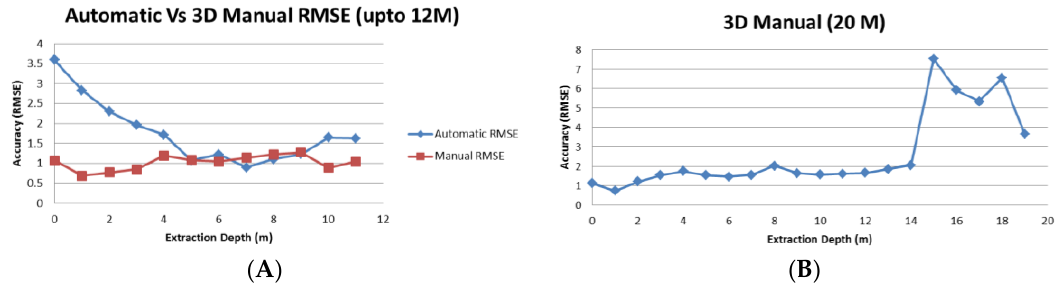
Figure 4. Comparisons between CHS survey data and stereo photogrammetry approaches for the entire WorldView-2 image and an inset area. ( A , B ): CHS survey data. ( C , D ): manual approach results. ( E , F ): automatic approach results. All share the same colour scheme shown in the legend. Imagery © 2015, DigitalGlobe, Inc.